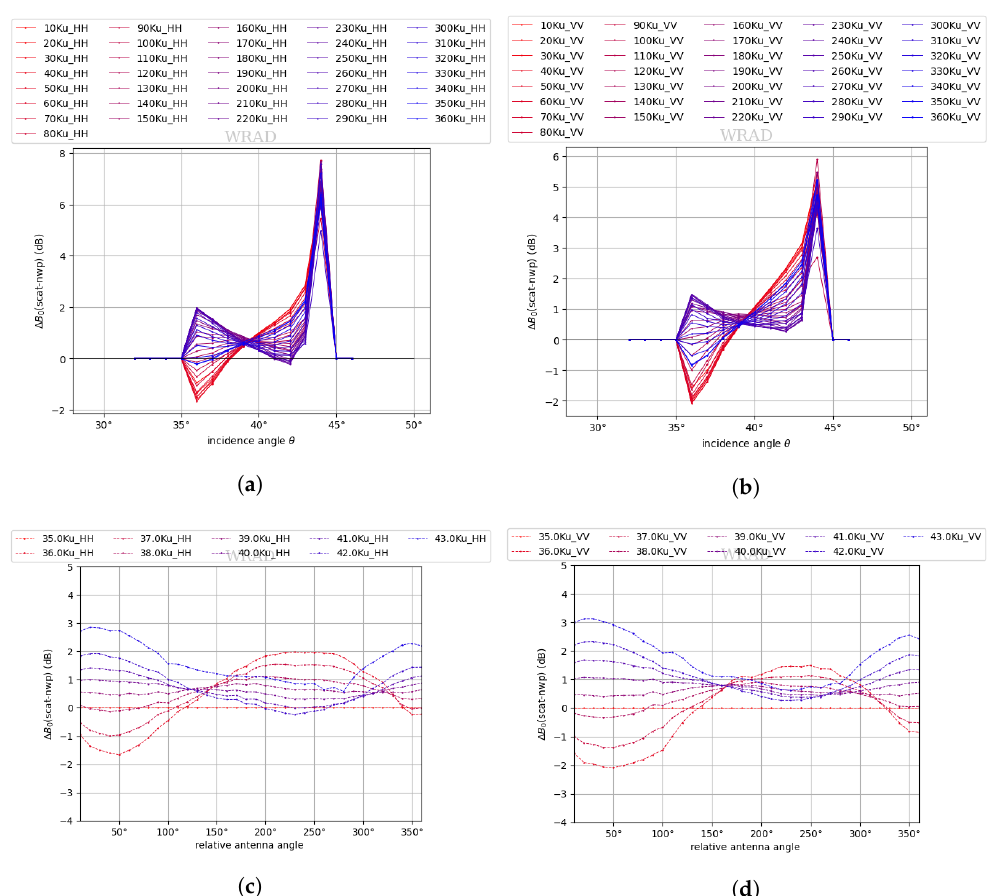
Figure 11. Ku-band NOCant (NOC as a function of incidence angle and relative antenna angle) for descending orbits. The upper panel is as a function of incidence angle ( x -axis) per relative antenna angle (red to blue lines), the lower panel is as a function of relative antenna angle ( x -axis) per incidence angle (red to blue lines): ( a ) and ( c ) HH polarization; ( b ) and ( d ) VV